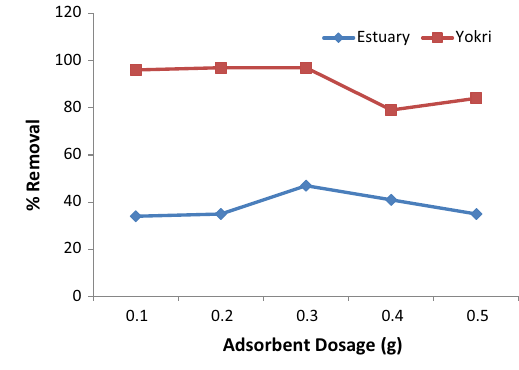
Fig. 4 Effect of adsorbent dosage on the sorption of crude oils onto